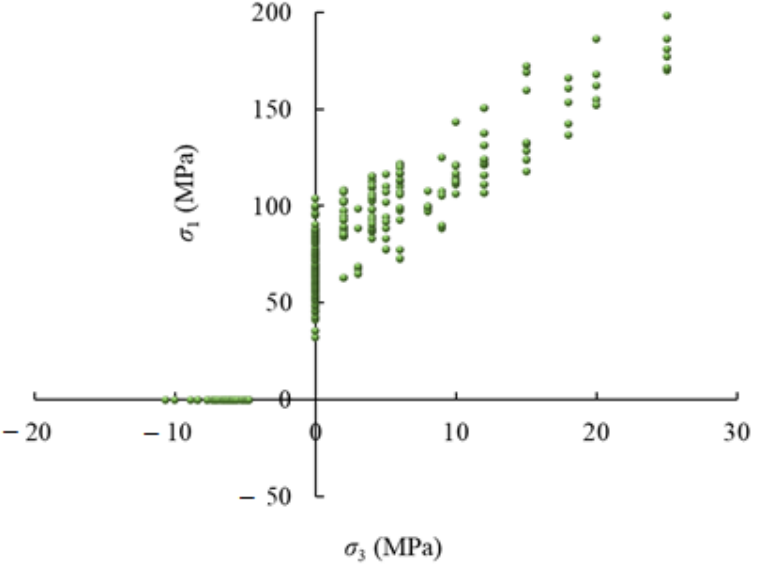
Figure 4. The experimental data.